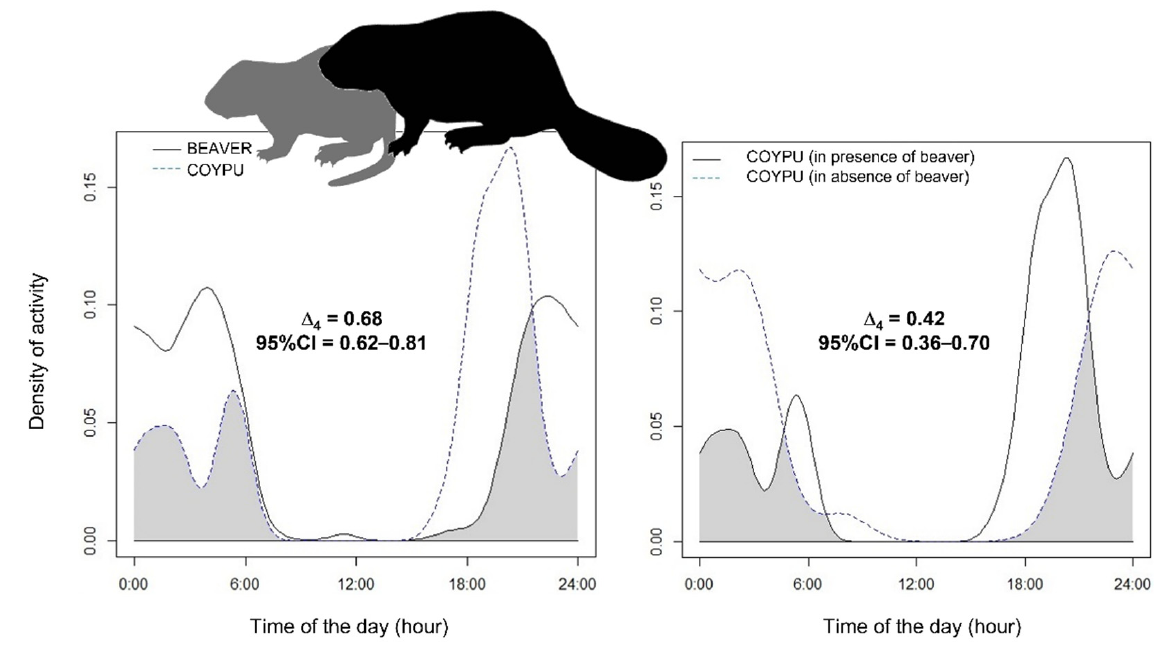
Figure 5. Interspecific overlap of activity patterns expressed as kernel density estimates (coefficient ∆ 4 ) between the Eurasian beaver and the coypu (on the left ) in Central Italy. On the right is the overlap of activity rhythms between coypus in areas with and without beavers on the Merse river; 95% CI = 95% Confidence Intervals.